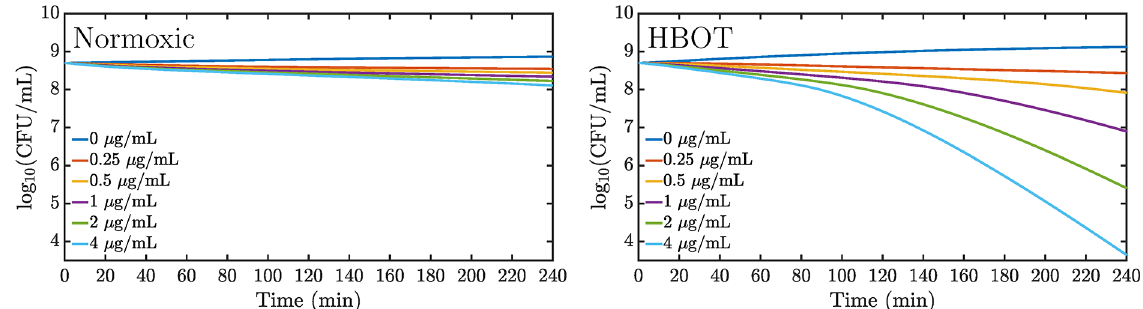
Fig 5. Predicted volume-averaged time kill curves for normoxic oxygen treatment and HBOT. Different dosing schemes over 4 hours of treatment simulated in a 5 mm biofilm model. The initial ciprofloxacin concentrations in the 1.25 mm supernatant are displayed in the figures while the fully equilibrated concentrations are 5 times lower. Left: Normoxic treatment. Right: Hyperbaric oxygen treatment.